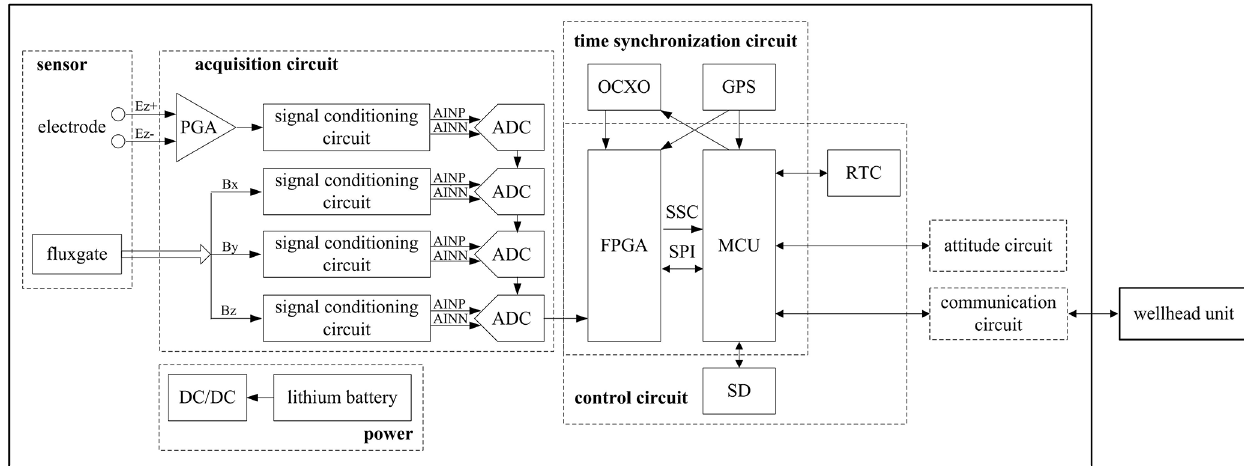
Figure 3. Block diagram of the internal hardware architecture of the borehole EMR. The microcontroller unit (MCU) refers to AT91SAM9G45.